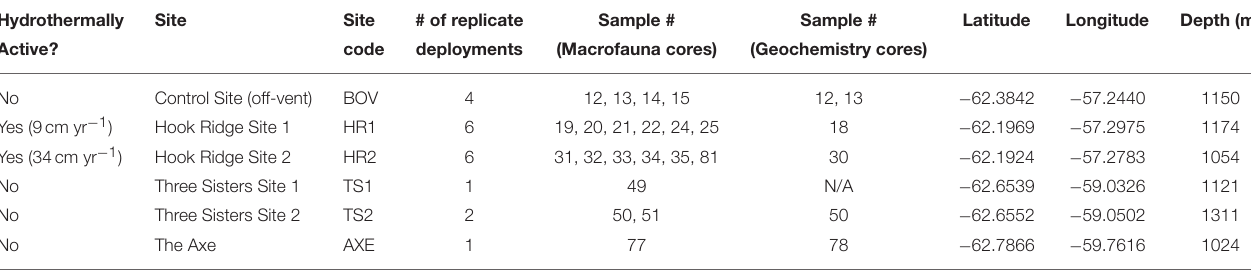
TABLE 1 | List of sampling locations and # of deployments. Hydrothermally Site Sample # Sample # Latitude Longitude Depth